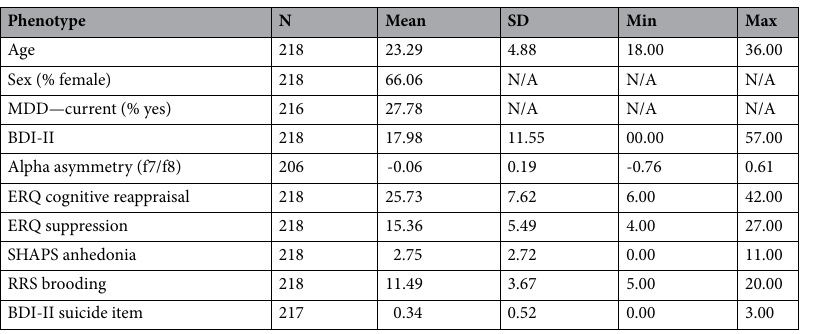
Table 1. Descriptive statistics of depression relevant outcomes and covariates. SD standard deviation, Min minimum, Max maximum, MDD major depressive disorder, BDI-II beck depression inventory-II,